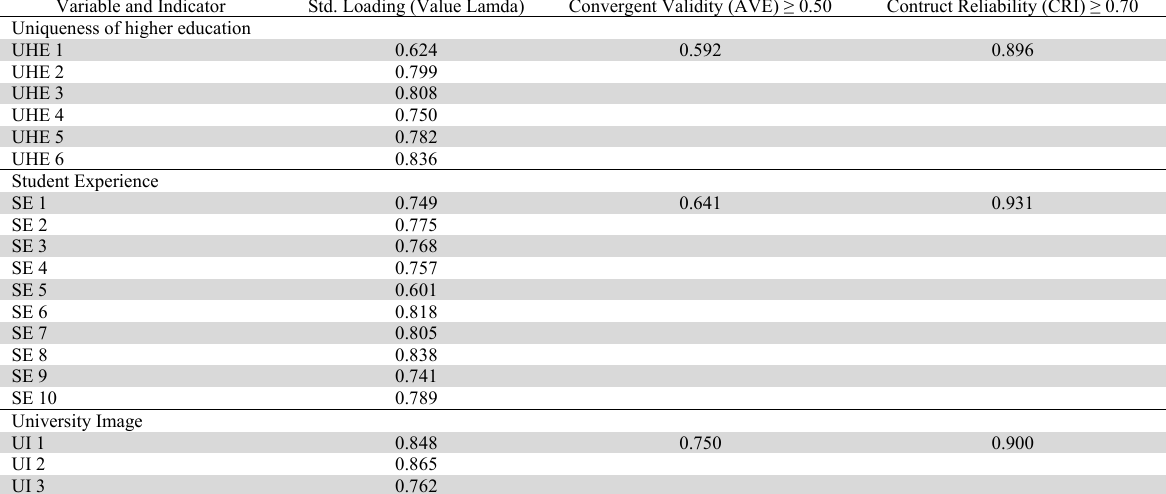
Measurement Validity and Reliability Construct Variable and Indicator Std. Loading (Value Lamda) Convergent Validity (AVE) ≥